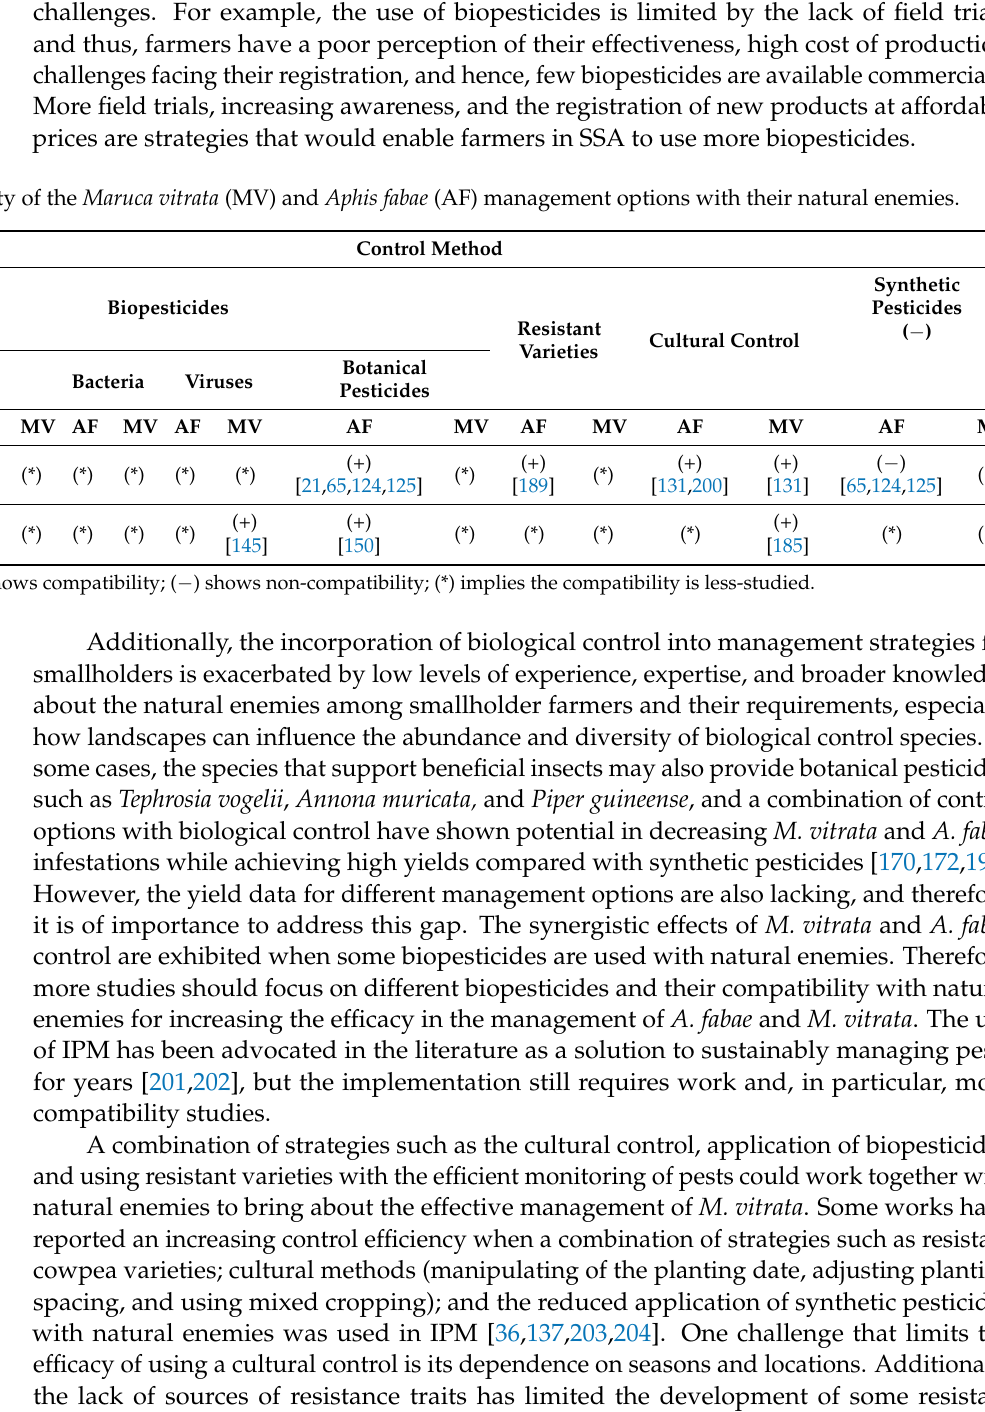
Table 7. The compatibility of the Maruca vitrata (MV) and Aphis fabae (AF) management options with their natural enemies.